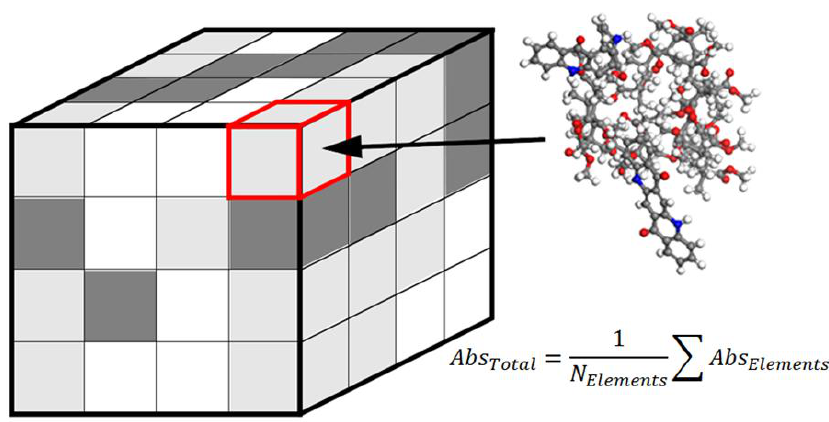
Figure 9. In systems with heterogeneous distribution of chromophores, a finite element approach to averaging may be used, whereby molecular modeling computes the